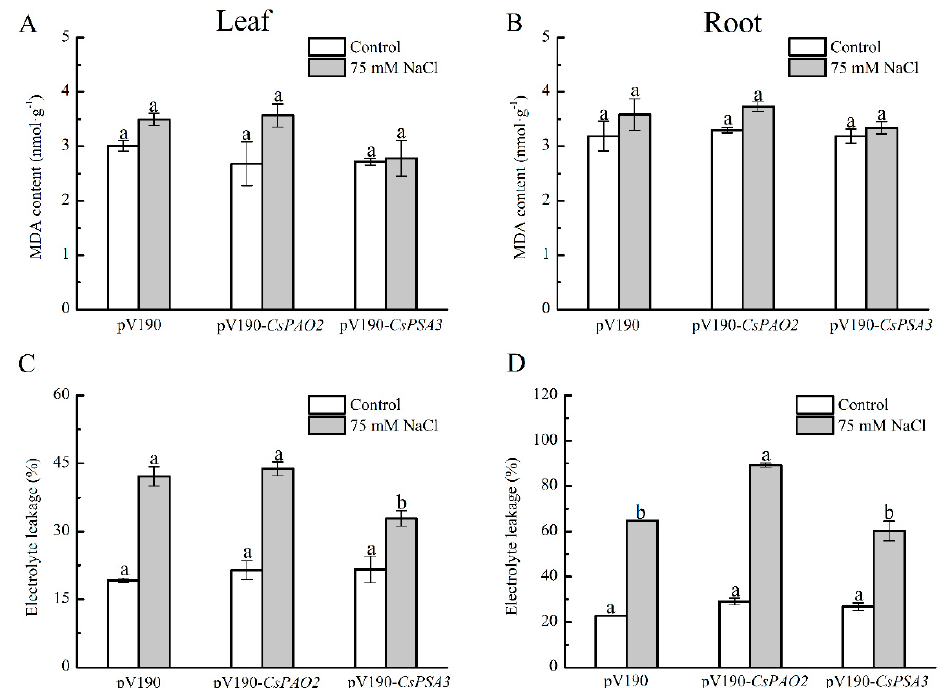
Figure 5. Effects of CsPAO2 and CsPSA3 silencing on MDA and EL of salt-treated cucumber. A, B, MDA content in leaf ( A ) and root ( B ). C, D, EL in leaf ( C ) and root ( D ). Gene-silencing plants cultivated in nutrient solution were treated with 75 mM NaCl for 3 days. The different letters indicate significantly different test index values between different gene-silencing cucumber plants under the same treatment ( p < 0.05) according to Tukey’s test.